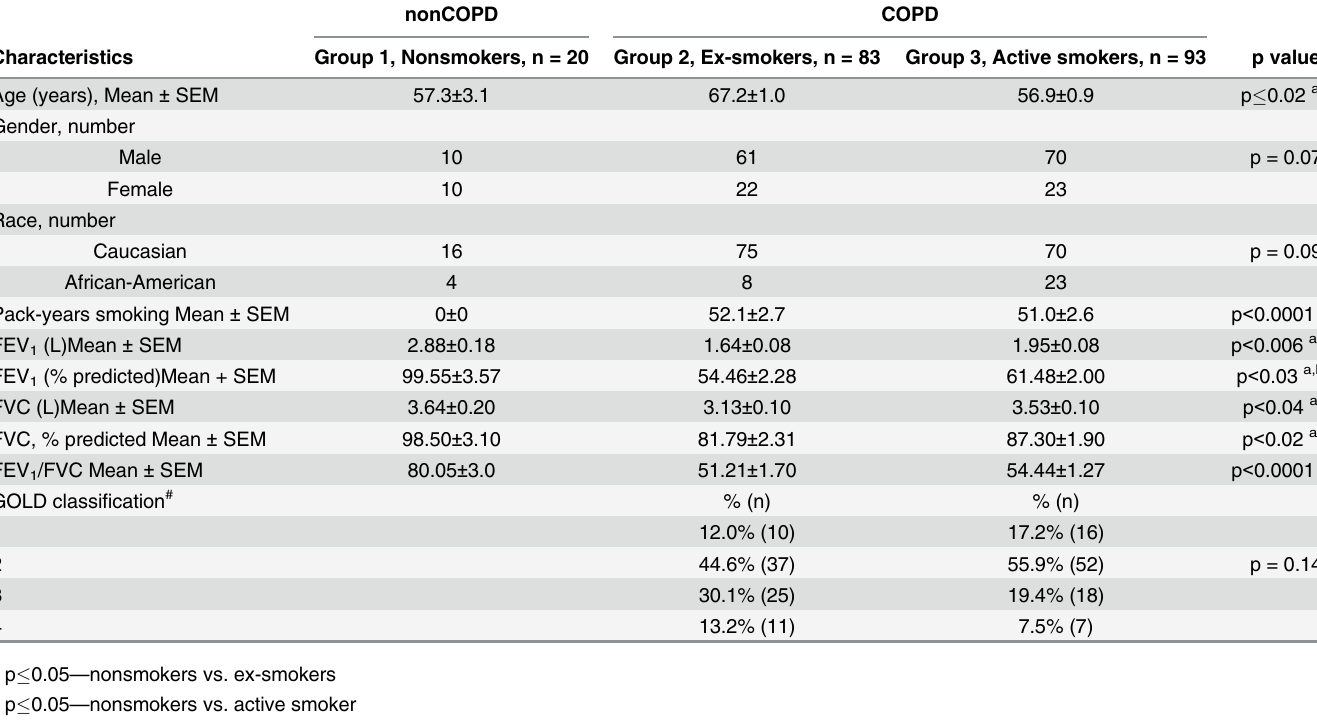
Table 2. Demographic characteristics: Total study participants. Data are expressed as mean ± SEM.